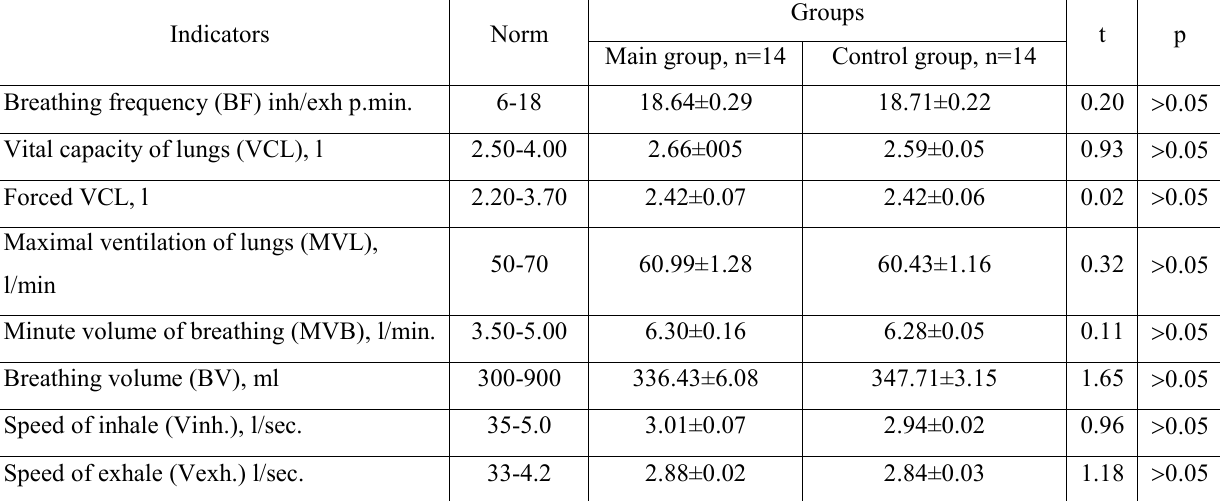
Spirographyc indicators of main and control groups’ patients received at primary examination (М  m) Indicators Norm